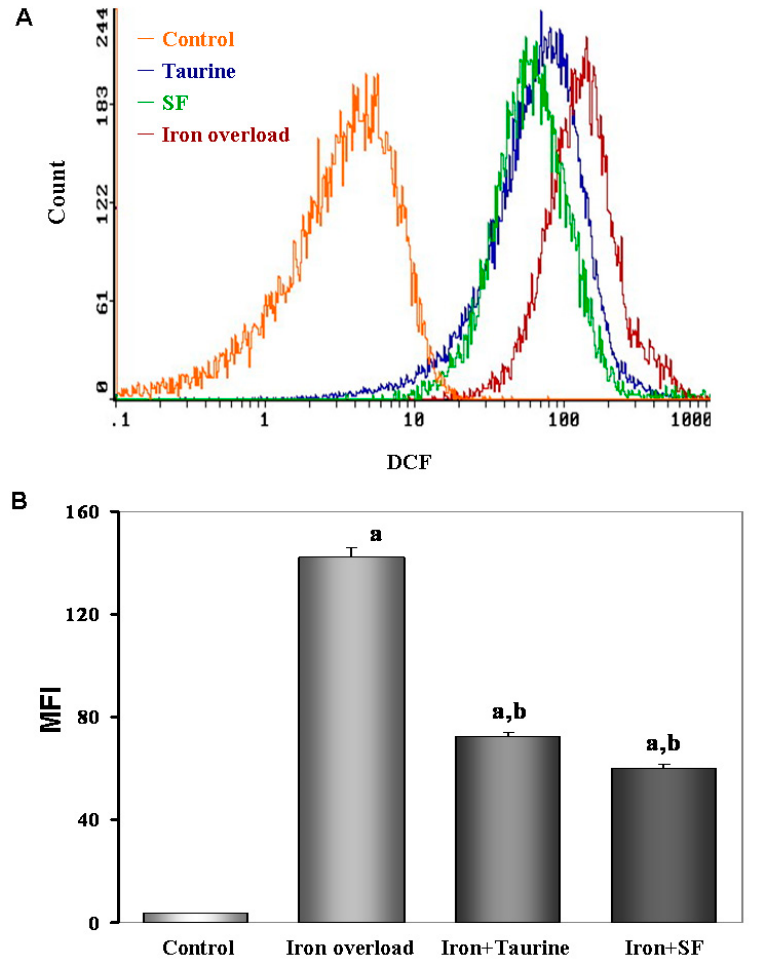
Figure 4. The effect of TAU or SF on hepatic intercellular ROS generation in iron-overloaded mice. ( A ) Cellular ROS contents were measured by flow cytometry. The incubation methods of every group were the same as we described in the Materials and Methods. Hepatocytes were then cultured for 20 min in the dark. All cells harvested for DCFH-DA incubating and measured using flow cytometry system; ( B ) Quantitative analysis of mean fluorescence intensity (MFI) of DCF. Data represents mean ± SE of 12 independent experiments. a: p < 0.01, vs. control group; b: p < 0.01, vs. iron overload group.